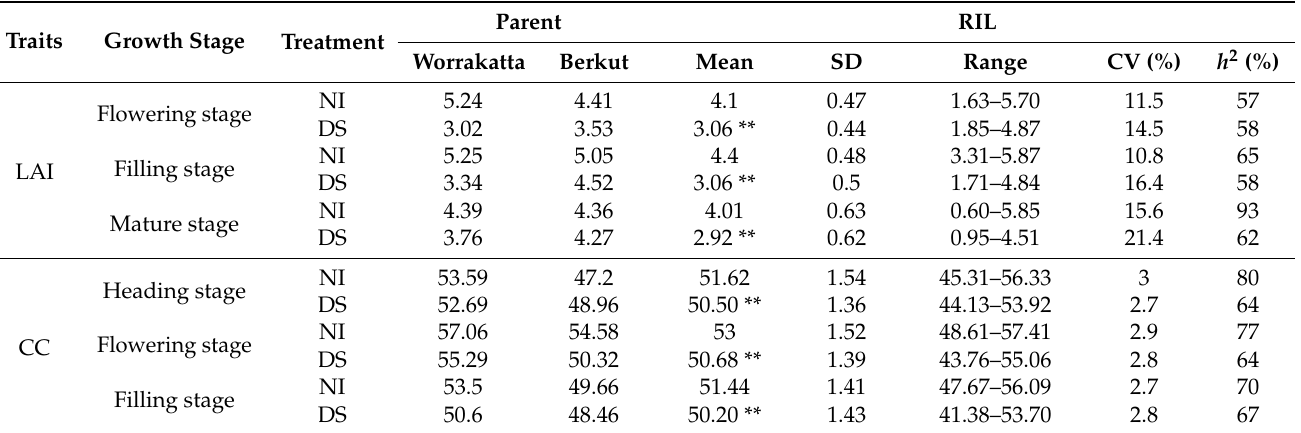
Table 4. Genetic variation of predicted LAI and CC of wheat cultivars Worrakatta and Berkut and their progeny recombinant inbreeding lines (RILs).